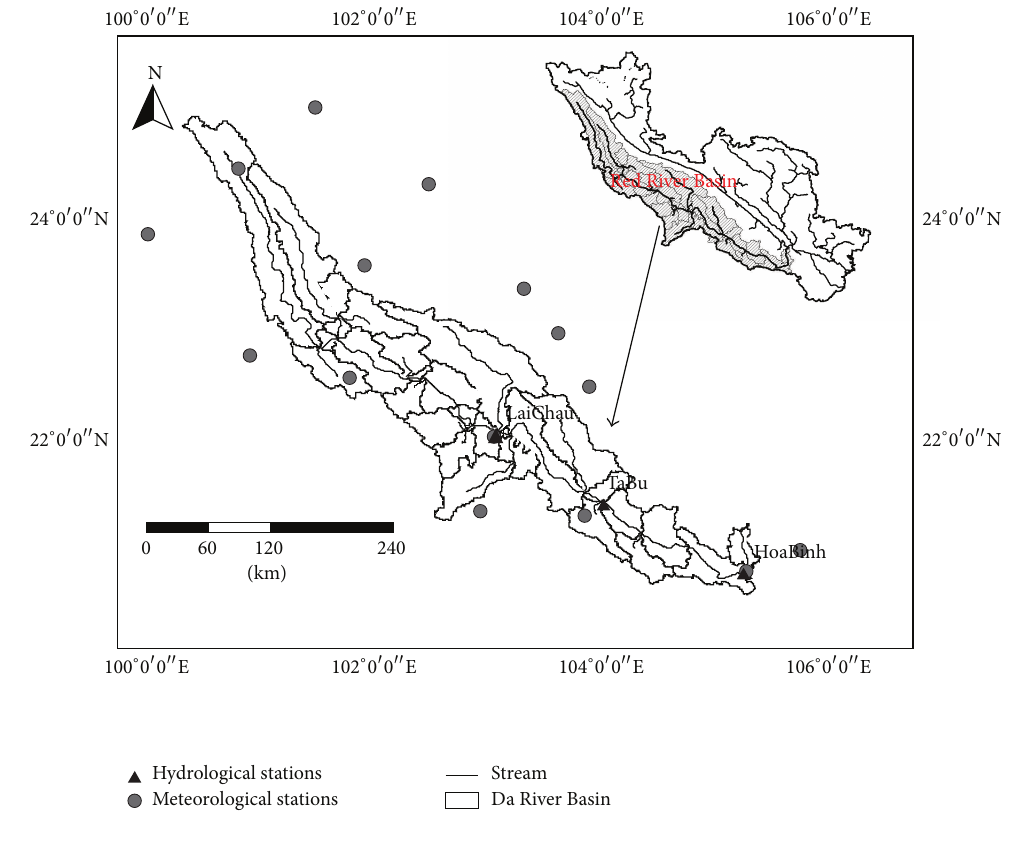
Figure 1: Location of the Da River Basin and the meteorological stations.